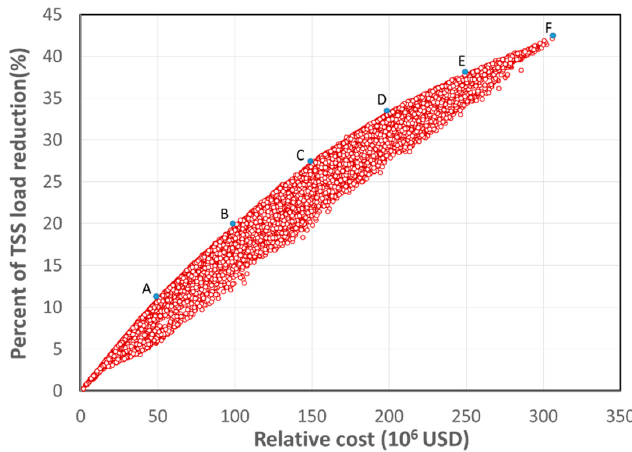
Figure 3. Total suspended solid (TSS) cost–effectiveness curve.